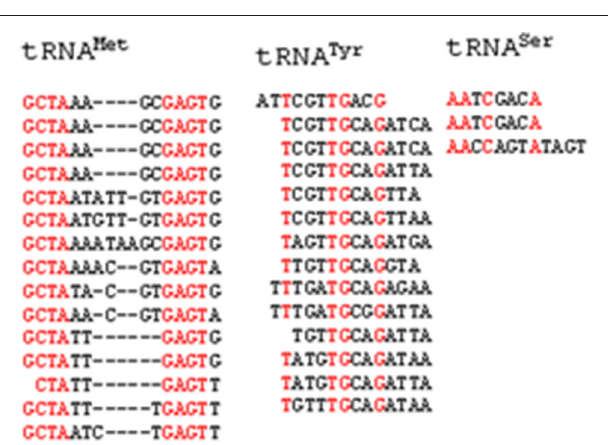
FIGURE 3 | Conserved consensus sequence of intron of O. sativa tRNA. tRNA Met contains G-C-T-A and G-A-G-T, tRNA Tyr contains x-T-x 3 -T-G-x 2 -G and tRNA Ser contains A-A-x-C-x 3 -A conserved consensus sequence.